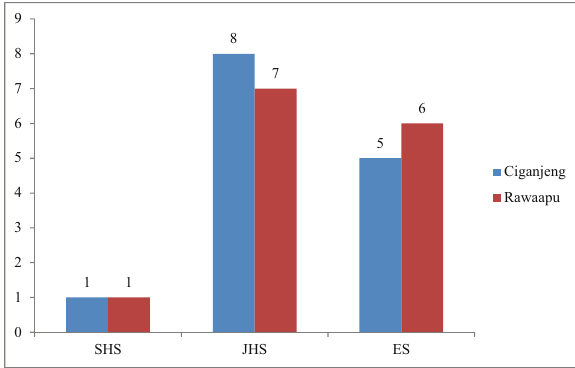
Figure 4: Level of education distribution of farmers